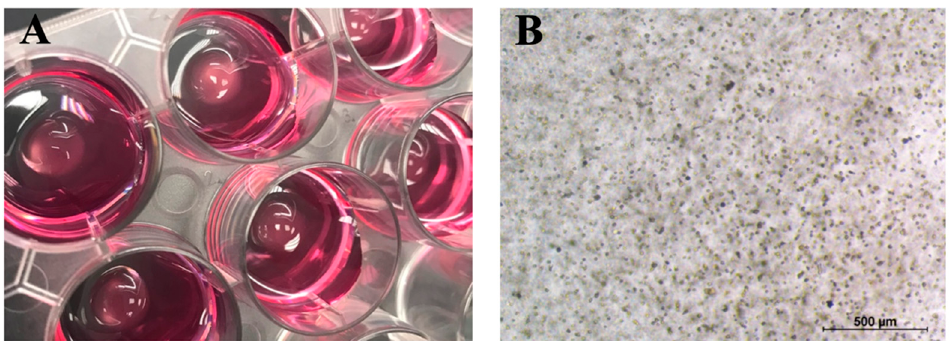
Figure 4. The generation of CS-Tyr-Gel/Cells composites. ( A ) Set CS-Tyr/Gel hydrogel with the encapsulated cells. ( B ) Visualization of cell distribution inside the hydrogel composite under the light microscope. The representative CS-Tyr/Gel/BMMSCs composite is shown.